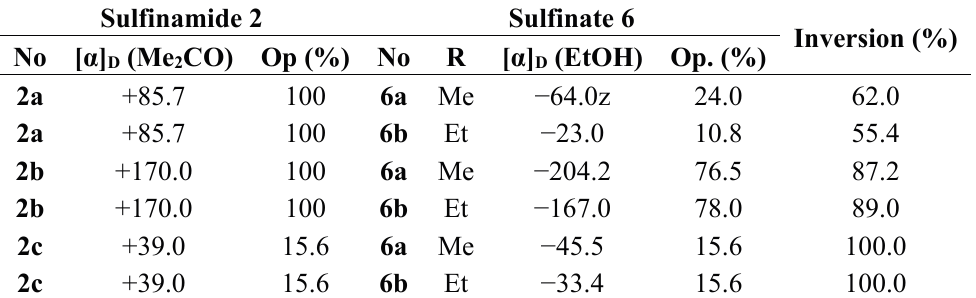
Table 4. Stereoselective synthesis of optically active O -alkyl benzenesulfinates ( 6 ), PhS(O)OR, from benzenesulfinamides (+)-( S )- 2 using trifluoroacetic acid as catalyst. Sulfinamide